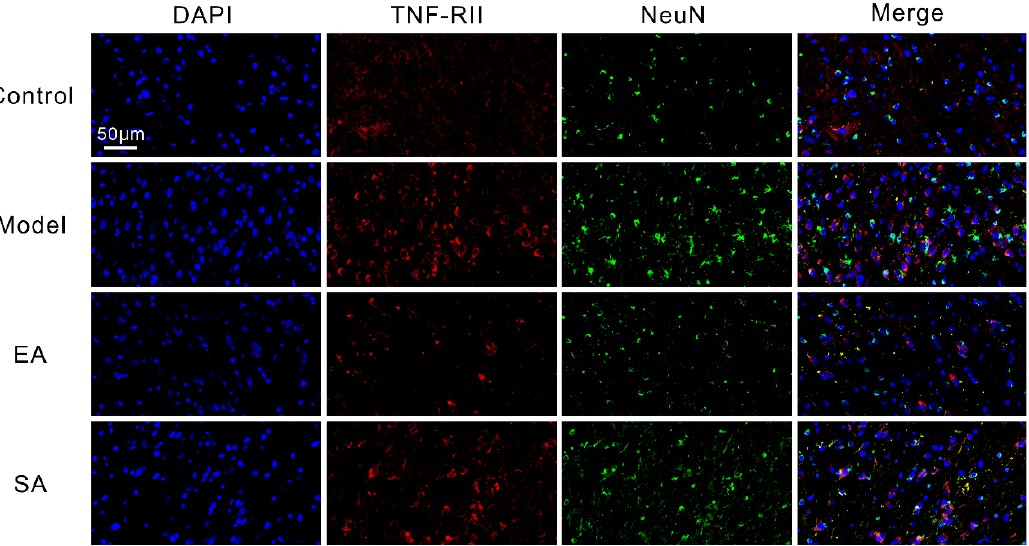
Figure 4. Representative immunofluorescent inflammatory factor receptor TNF- α RII in TNC. Shown are NeuN (green) and inflammatory factor receptor TNF- α RII (red) double-labeled cells in the TNC (400×, Scale bar = 50 µm, n = 4, three sections/rat).